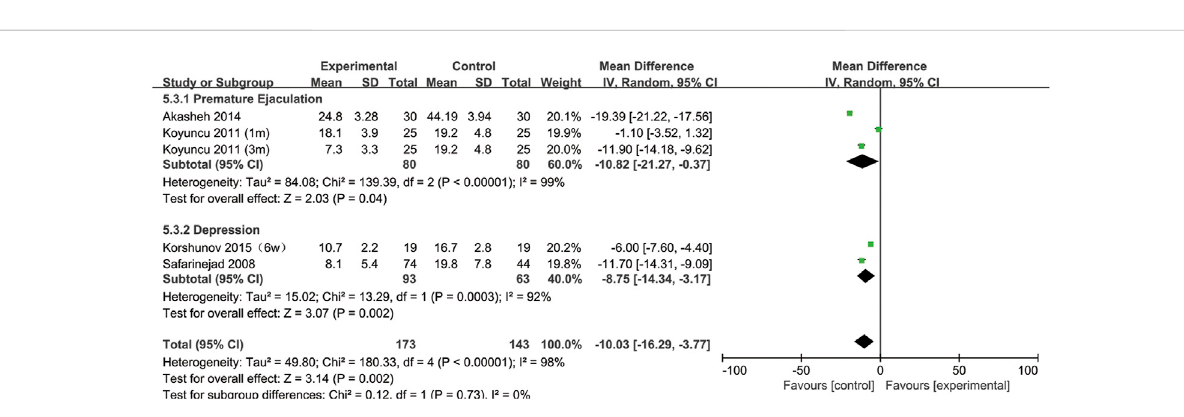
Subgroup of the association between normal sperm morphology and different basic disease.